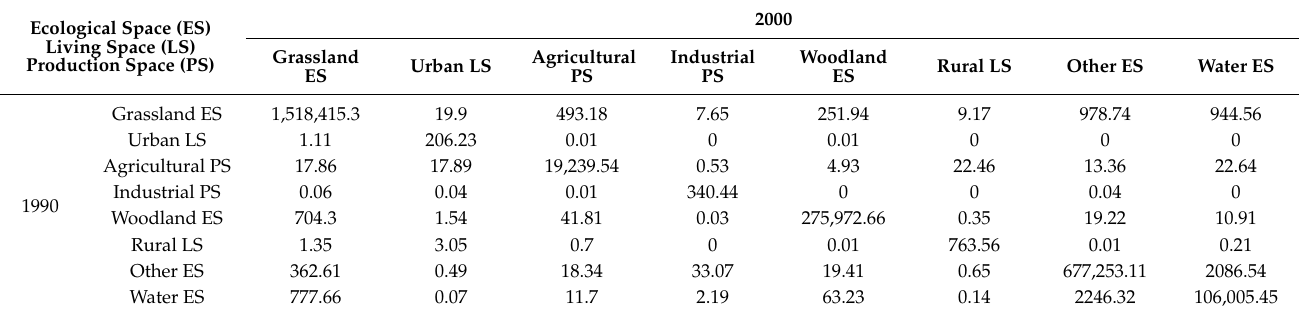
Table A2. Transfer matrix of land use structure change from 1990 to 2000 (km 2 ).